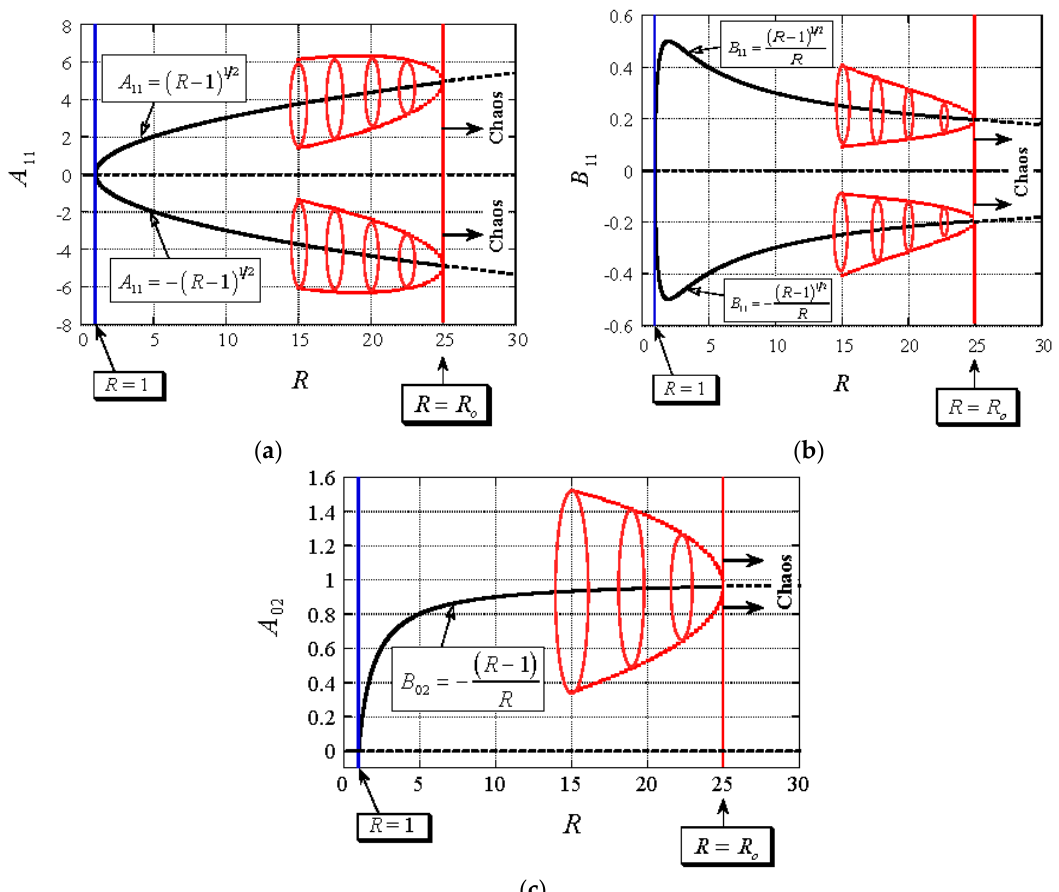
; ( b ) B ; and ( c ) B , as a function of R on 11 11 02